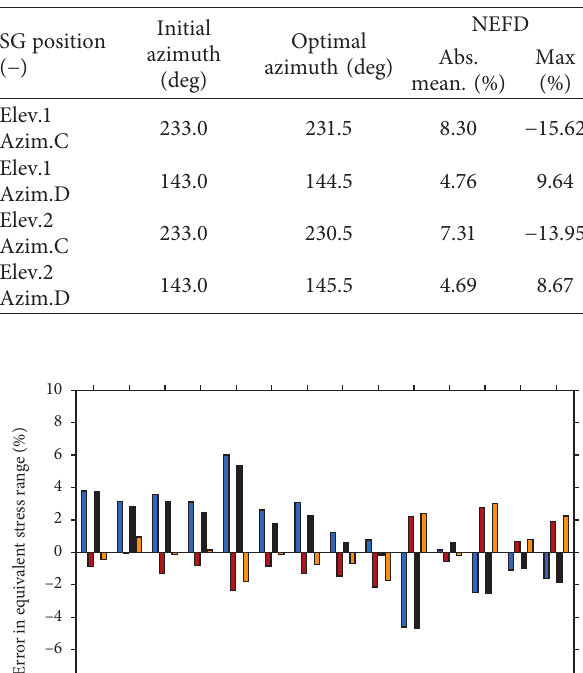
Table 3: Optimal azimuth of SG position.